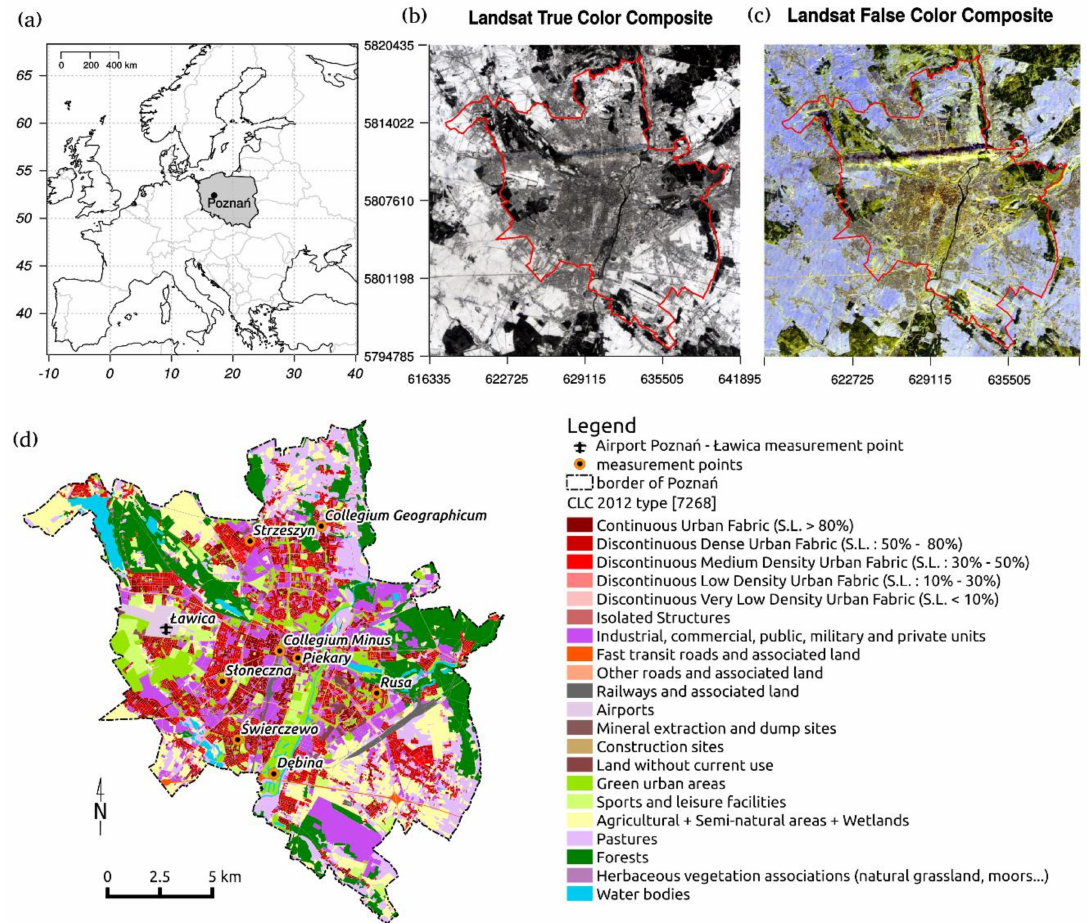
Figure 1. Location of Pozna´n ( a ) as well as Landsat 5 (thermal) 8-bit greyscale image of the study area ( b ) and image composite of three infrared bands of the ETM+ radiometer RGB = 654 ( c ) (acquisition date: 9 January 2010) and location of measurement points against type of land use ( d ) (Urban Atlas